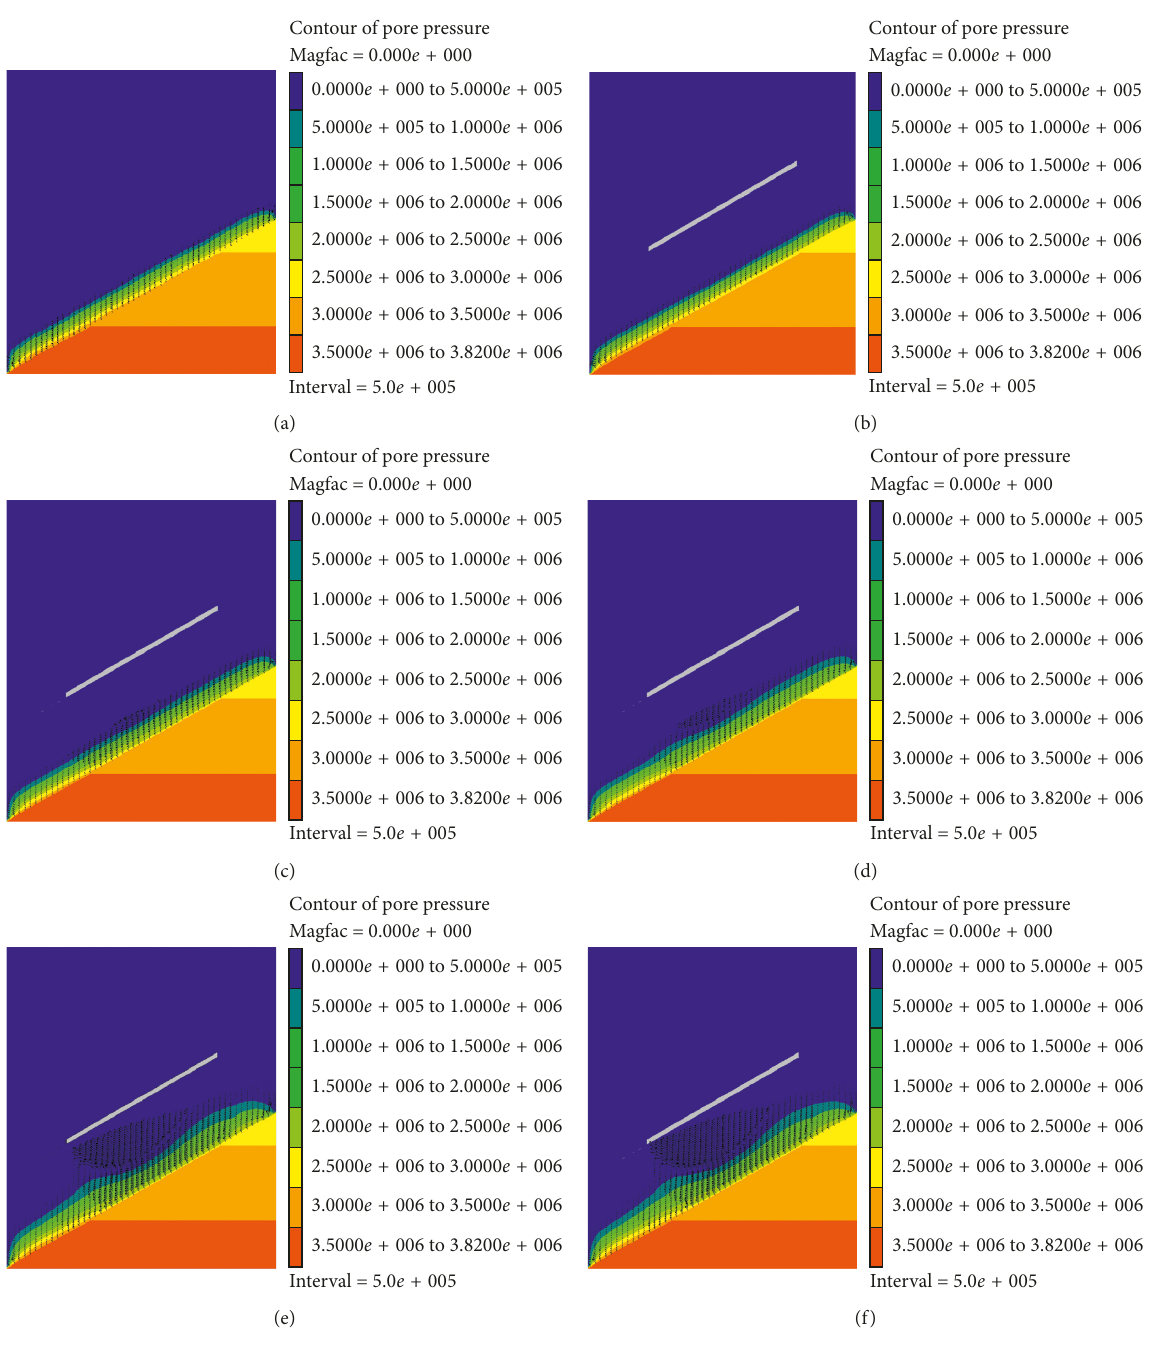
Figure 8: Pore water pressure and seepage vector distribution of workface floor along the inclined direction of the coal seam with the advancement of the workface (water inrush). (a) Original pore pressure. (b) Advanced 20m of workface. (c) Advanced 40m of workface. (d) Advanced 60m of workface. (e) Advanced 80m of workface. (f) Advanced 100m of